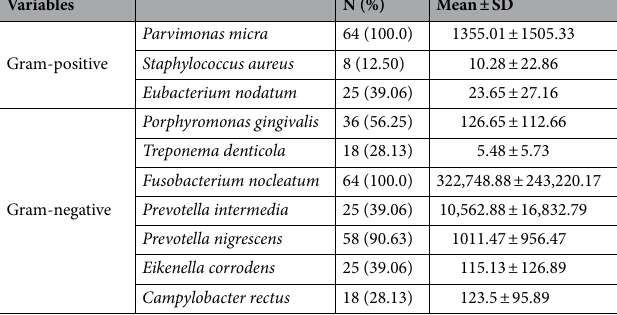
Table 3. Distribution of periodontal disease-causing bacteria in the study subjects (N = 64).